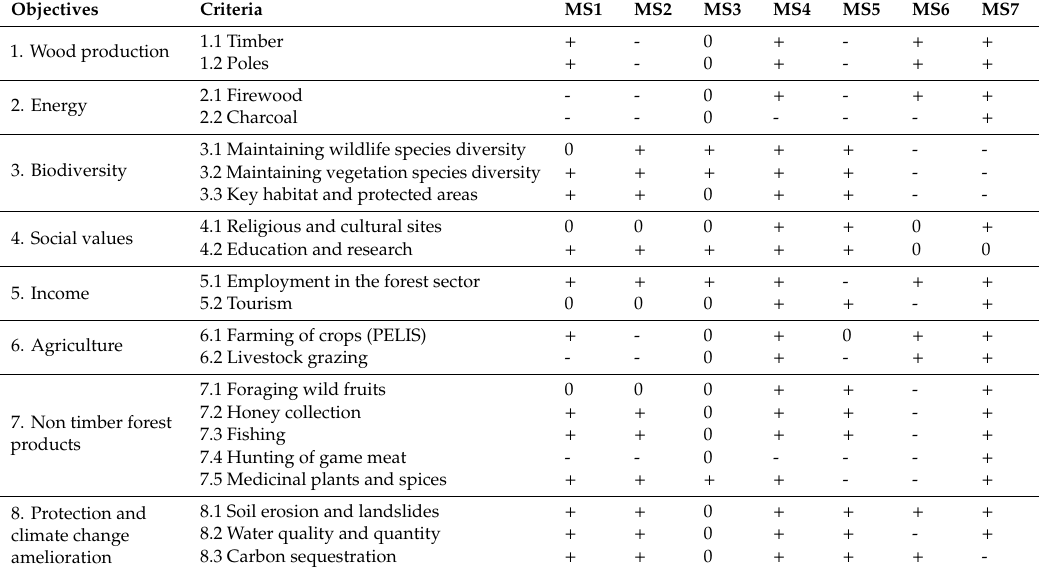
Table 2. Qualitative assessment of the seven management strategies (MS) based on objectives and criteria (O&C) to determine how they contribute to increasing the benefits obtained in